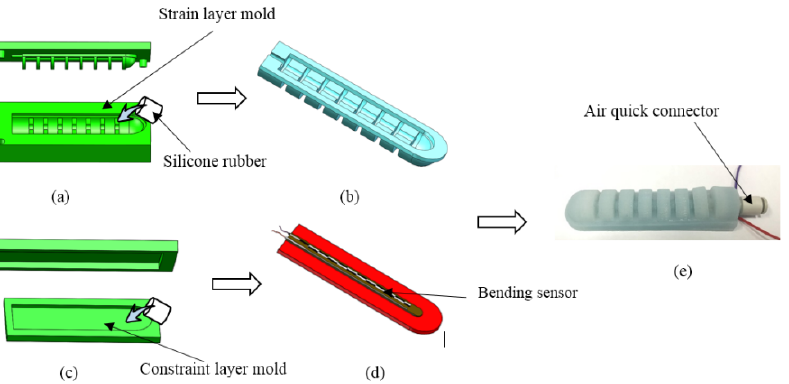
Figure 2. Soft actuator preparation flow chart. ( a ) Preparation of strain layer with mold. ( b ) Prepared strain layer. ( c ) Preparation of limiting layer. ( d ) Attachment of the bending sensor. ( e ) The assembled soft manipulator.